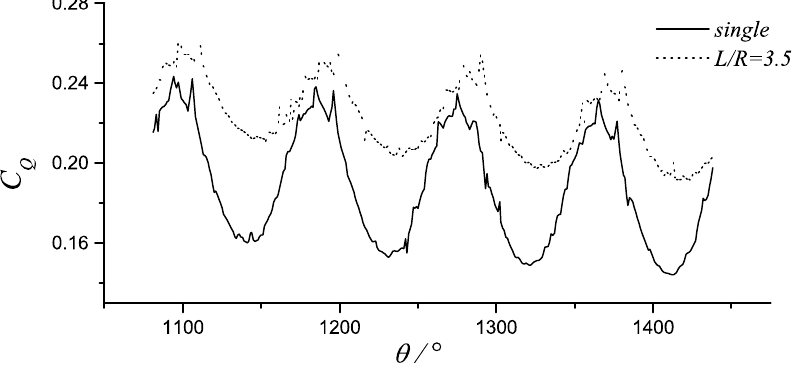
Figure 12. The comparison of the turbine torque coefficient in the parallel and single situation where Z = 4.